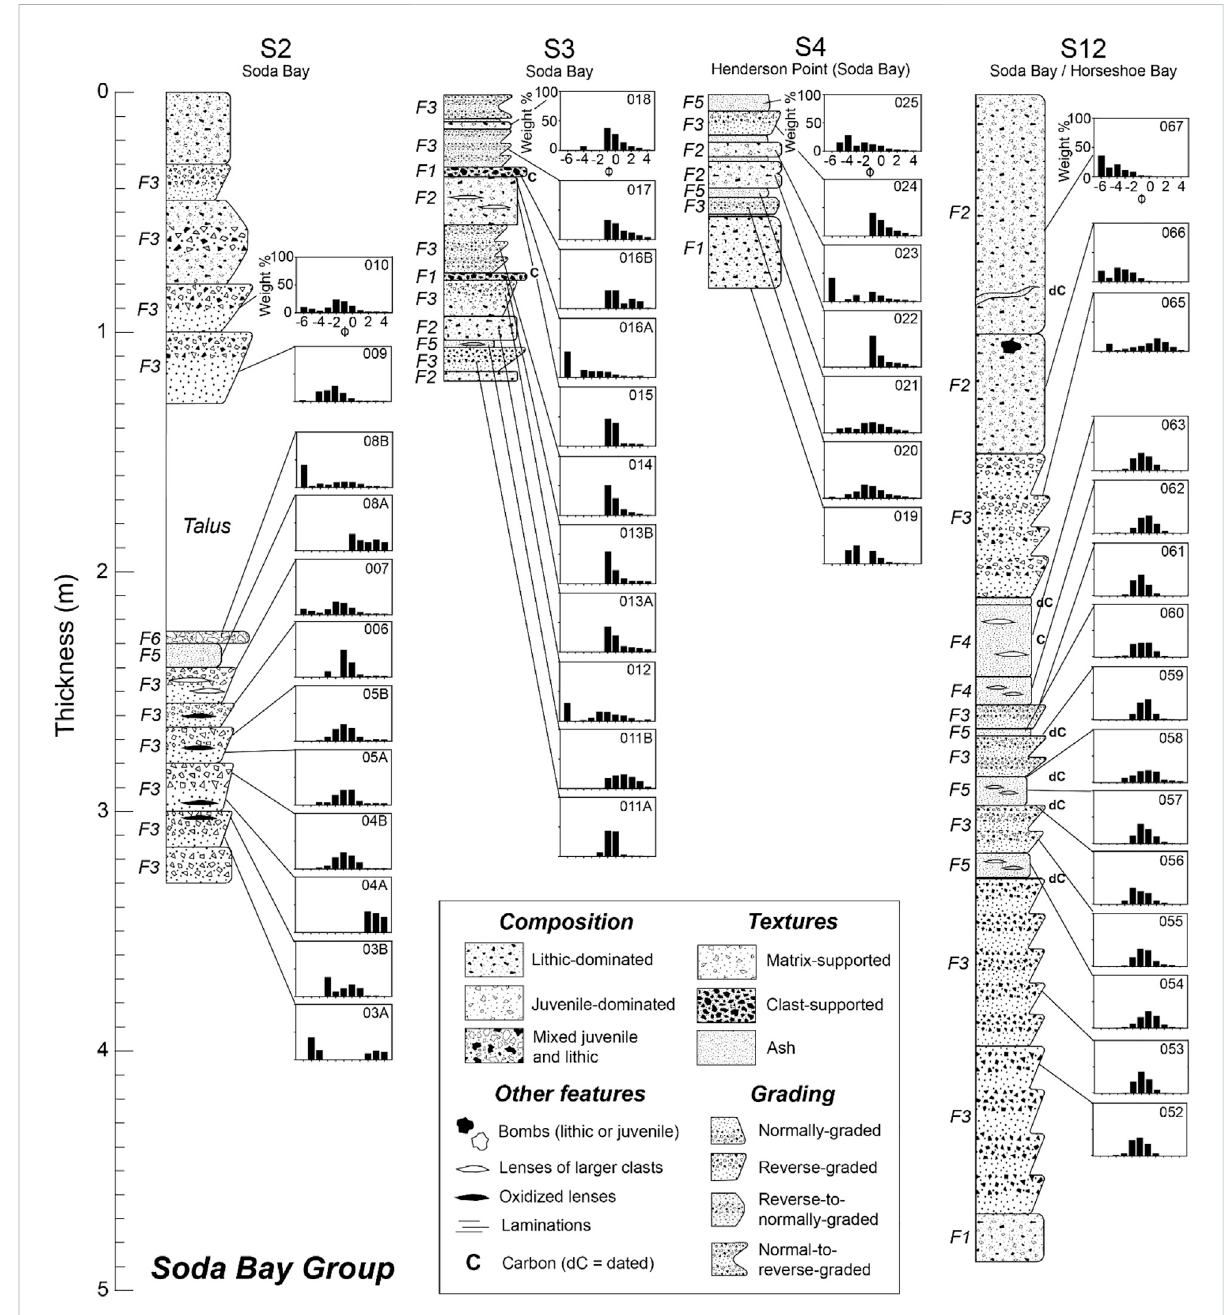
FIGURE 5 Stratigraphy of outcrops in the Soda Bay area of the CLVF, west of the Buckingham Peninsula. Average grain size is denoted by the horizontal width of the column (shorter = fi ner grain size, longer = coarser grain size), and relative clast sizes are also shown in the drawings. Layer widths are alsoscaled relativetothedominantgrainsizeinthedeposit(i.e.,smallergrainsizesarenarrower,largerarewider).Grainsizedistributionsareshown to the right of each column and are numbered by sample. Facies designations are shown to the left of each column. Locations where carbon was sampled (for example, S12 layer 063) are marked by a “ C. ” Columns are ordered by their geographic progression from west to east; no correlations or relationships to source vents are implied by this